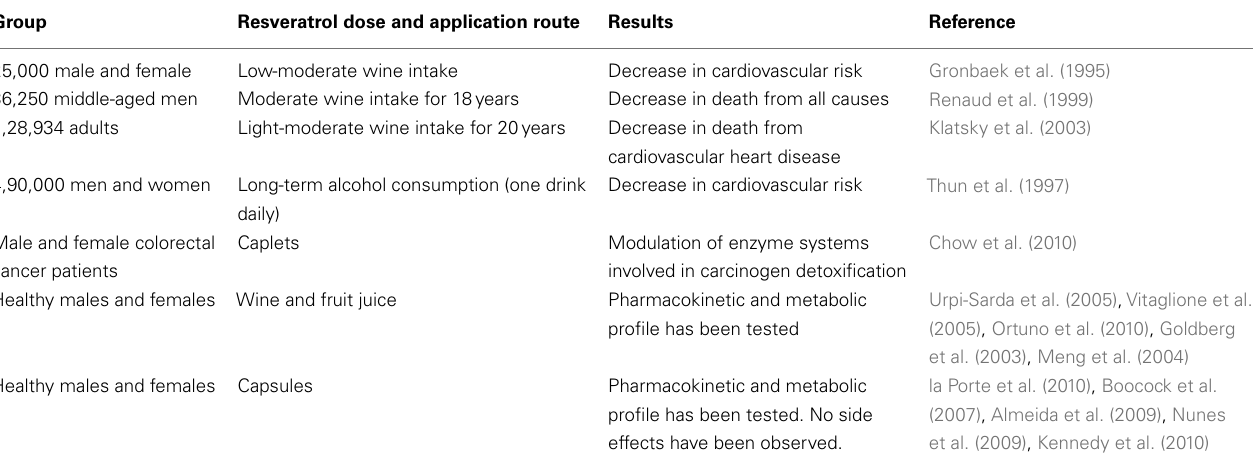
Table 1 | Clinical data and trials of resveratrol-containing interventions (Patel et al.,